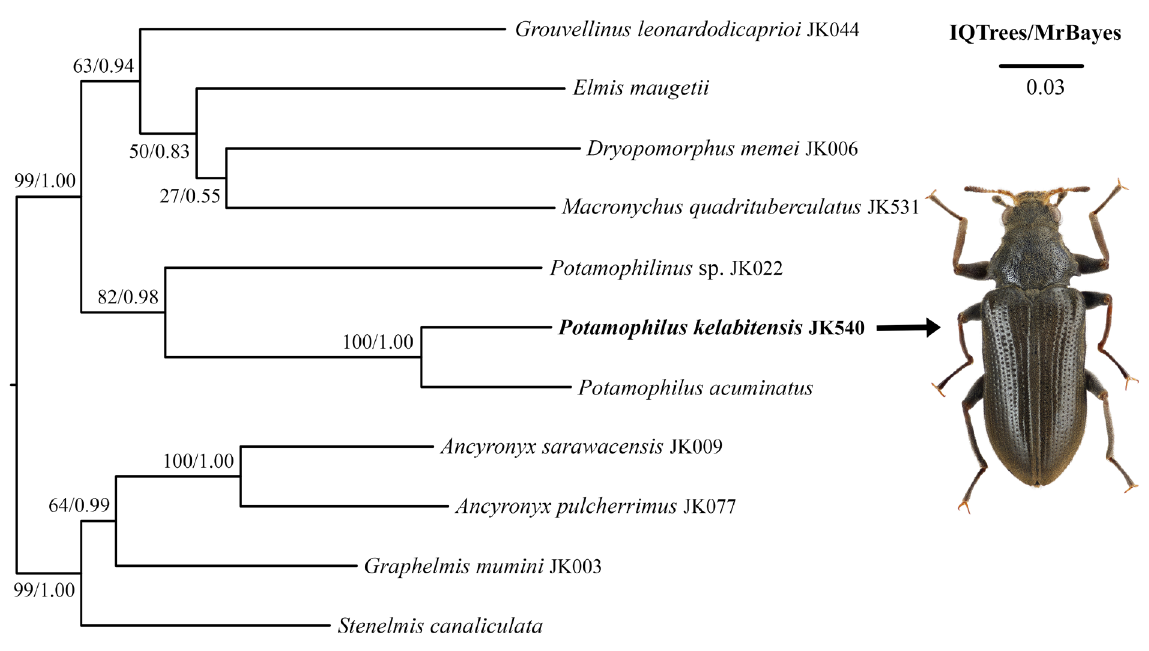
Fig. 1. Phylogenetic tree based on the nuclear 18S rRNA gene (592 nt), ArgK (677 nt), and the mitochondrial COI gene (603 nt). Bootstrap values for maximum likelihood conducted in IQTrees and posterior probabilities for Bayesian inferences conducted in MrBayes were mapped onto the best scoring ML tree. The scale bar denotes three substitutions per one hundred nucleotide